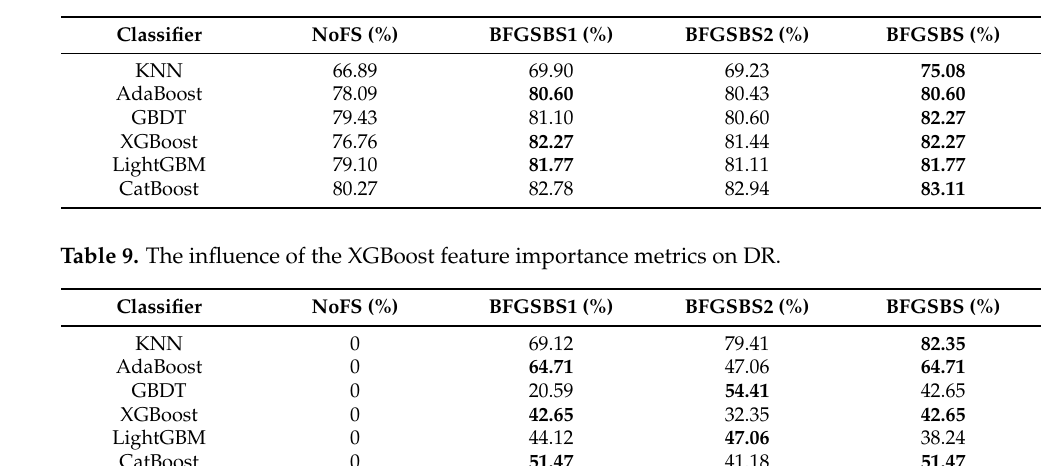
Table 8. The influence of the XGBoost feature importance metrics on the classification accuracy.